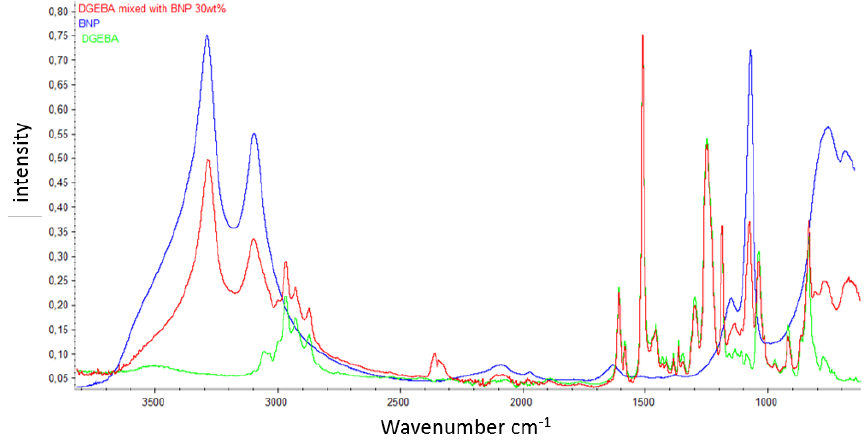
Figure E1. Room temperature ATR-IR spectra of BNPs, epoxy resin DGEBA, anhydride hardener MTHPA, and the thermally-cured DGEBA/MHTPA/imidazole(accelerator) with 100:90:1 mixing ratio and 120 curing temperature.